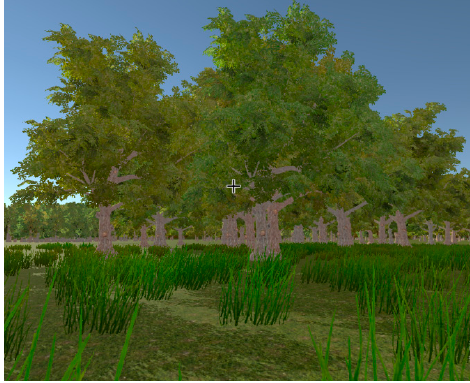
Figure 5. Screenshot of the virtual practice scene.